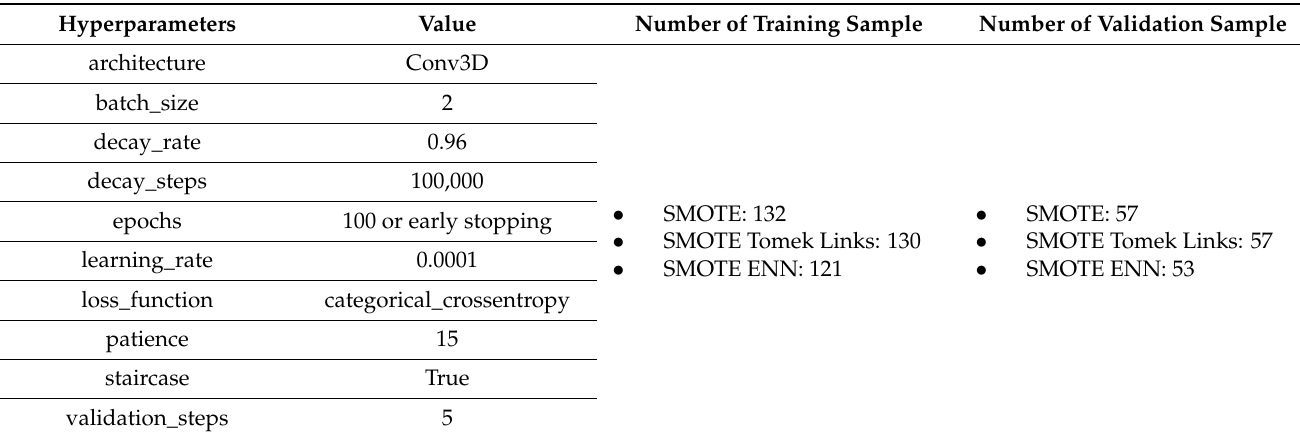
Table 3. Configuration used in the balancing strategy experiments with full epoch and early stopping runs for 6